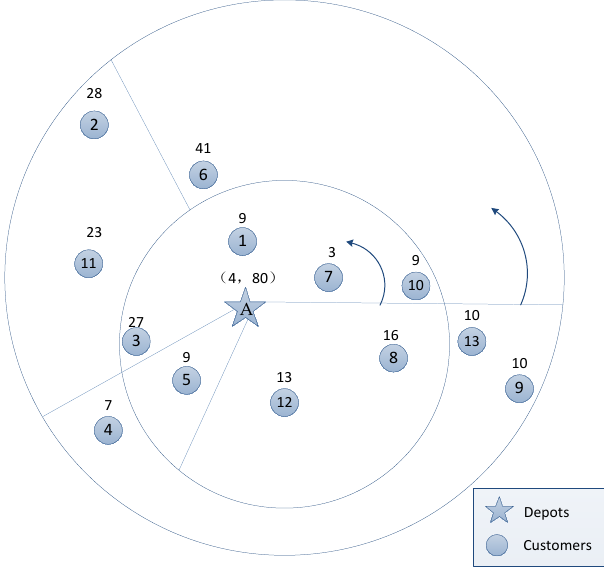
Figure 2. The sectors of depot A.